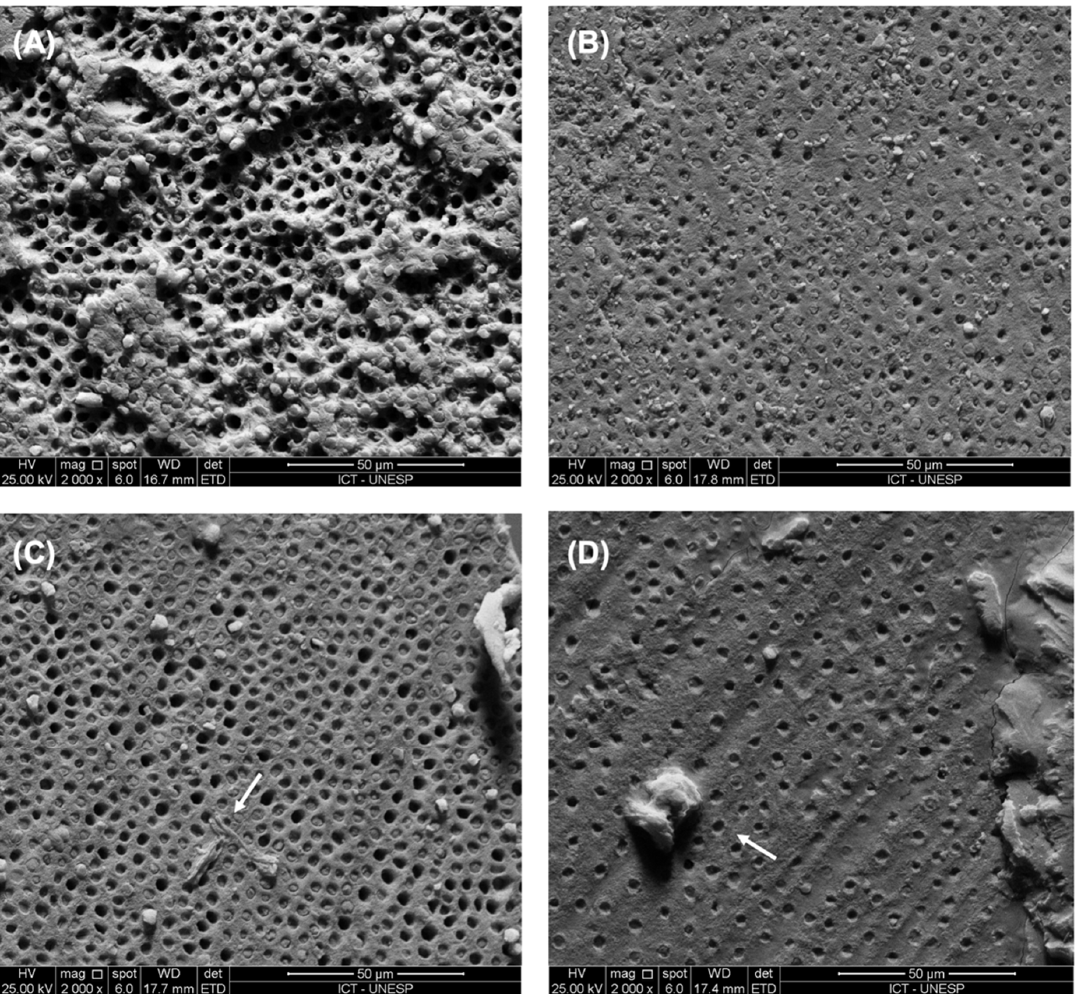
Figure 2. Representative failure modes observed from the dentin side of fractured composite-dentin sticks. ( A ) control group: some of the tubules were empty and had resin tags pulled out during microtensile testing. ( B ) Adhesive with 1 wt% nisin: fractured adhesive with surface of the hybrid layer showing dentin tubules. ( C ) Adhesive with 3 wt% nisin: dentin tubules with nisin clustering (arrow) between the dentin and the hybrid layer. ( D ) Adhesive with 5 wt% nisin: large nisin clustering (arrow) on the hybrid layer.